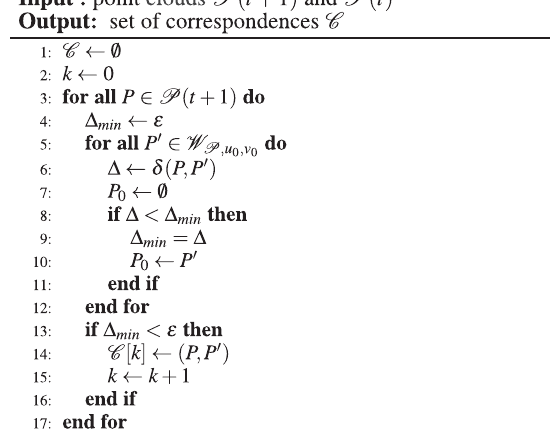
Frontiers in Virtual Reality |